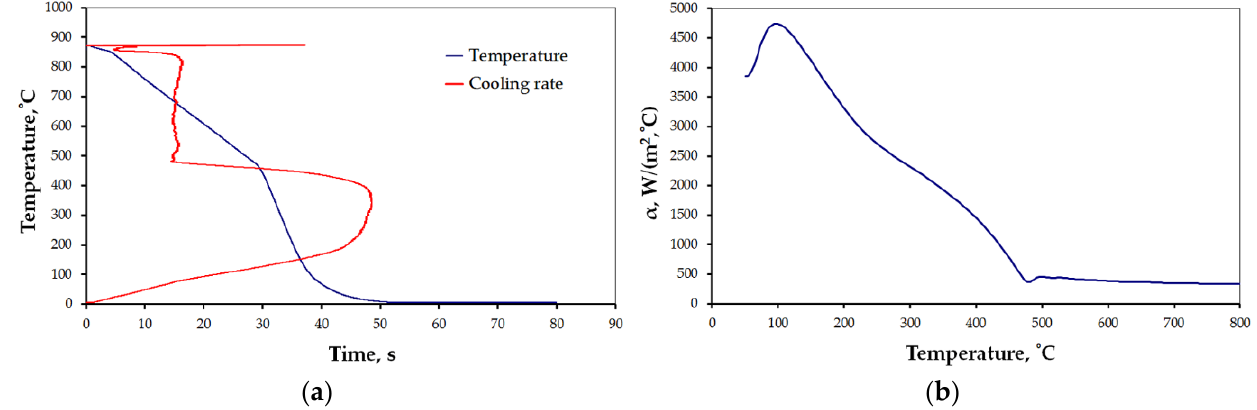
Figure 6. Results of measurement: ( a ) T = f( τ ) and v = f(T) , and ( b ) heat transfer coefficient for settings 1 (Table 1).